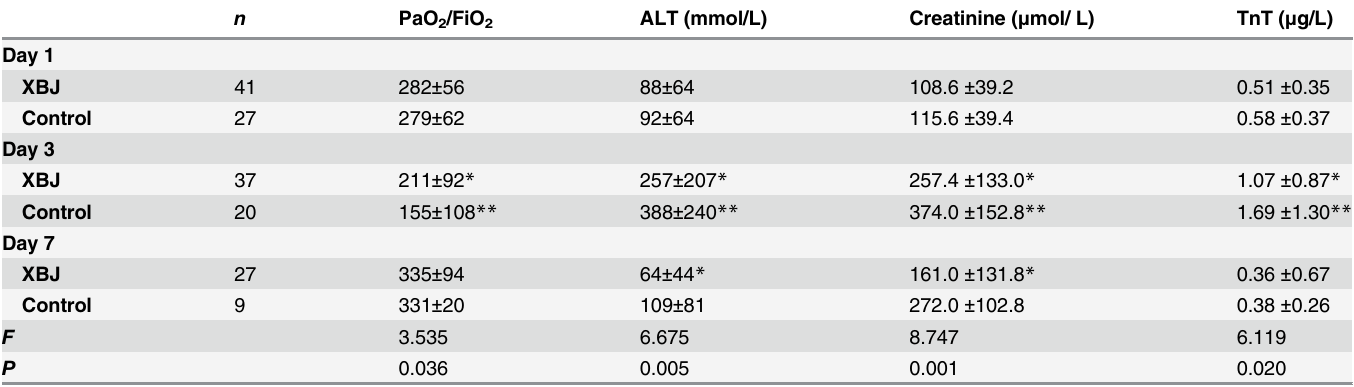
Table 4. Vital organ functions in both groups during XBJ